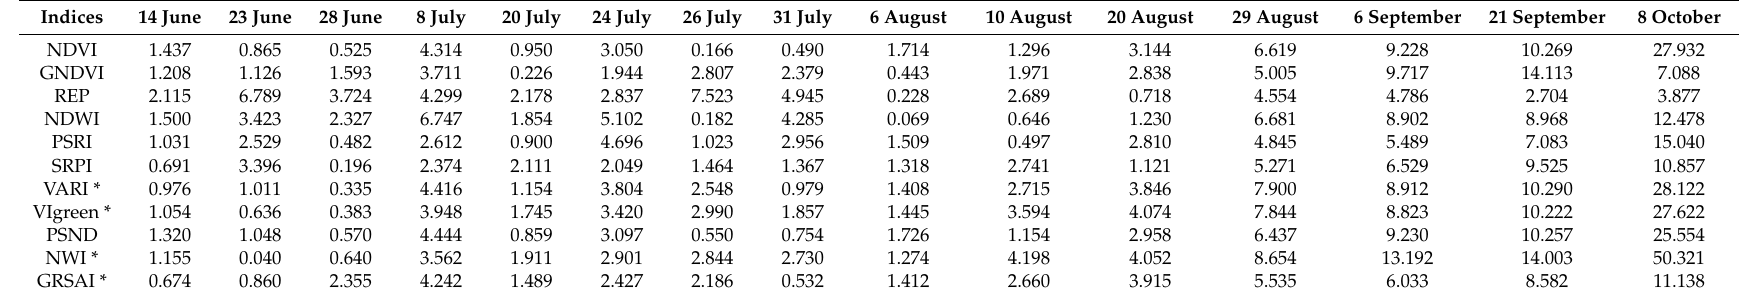
Table 2. Independent t -test results of different indices used to measure reflectance in infected and non-infected trees over time.